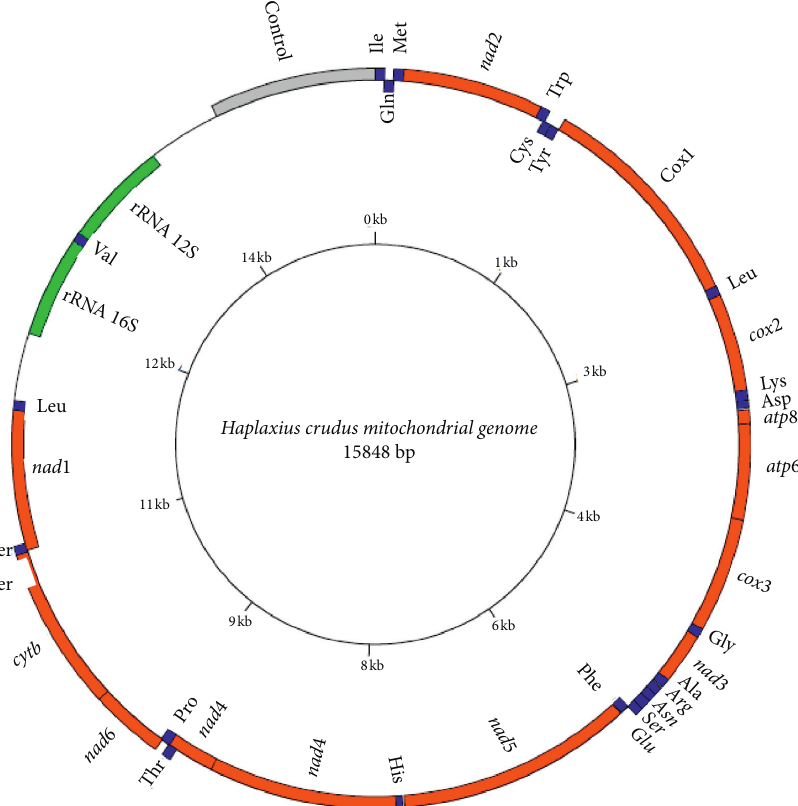
Figure 2: Map of the mitochondrial genome of Haplaxius crudus ; outer circle � positive strand, inner circle � negative strand, blue � tRNAs, orange � protein-coding gene, green � rRNA, and gray � control